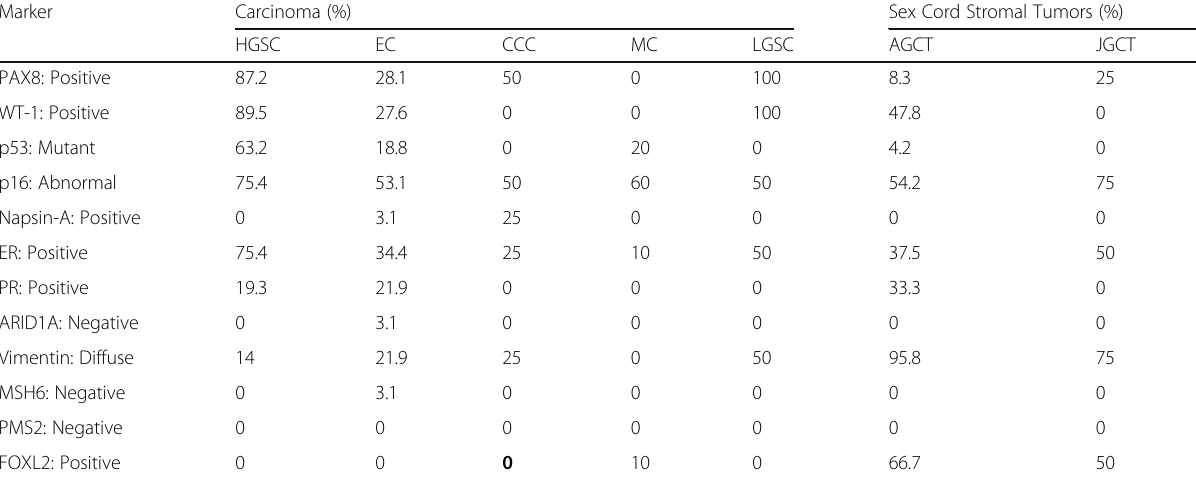
Table 2 Immunohistochemical marker expression across histotypes Marker